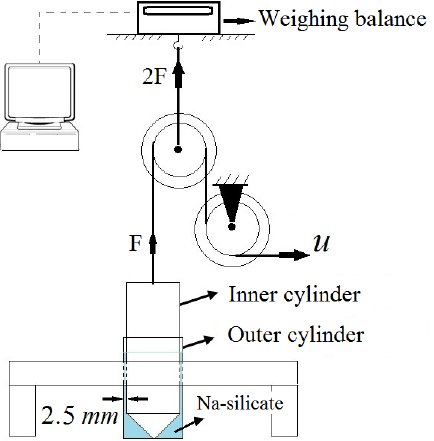
Figure 1. Schematic of the constructed gel strength measurement